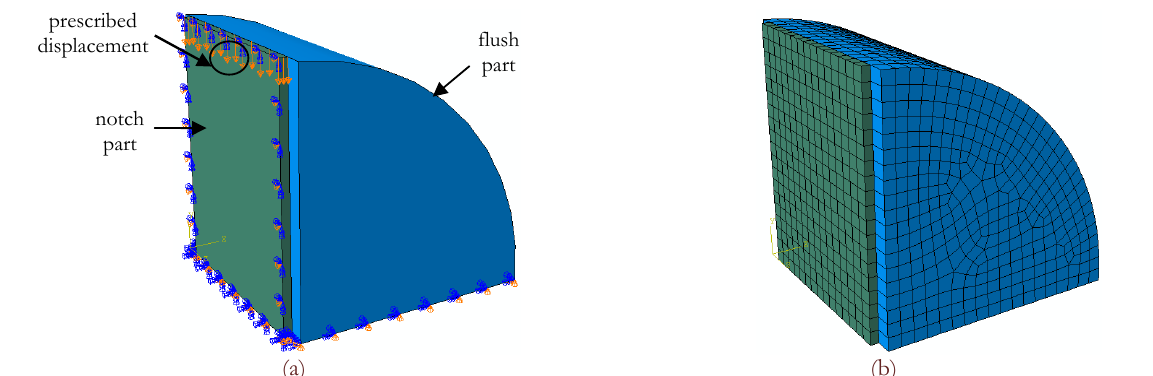
Figure 11: Three-dimensional view of numerical model [24]: (a) geometry, constraints and prescribed displacement, (b) finite element